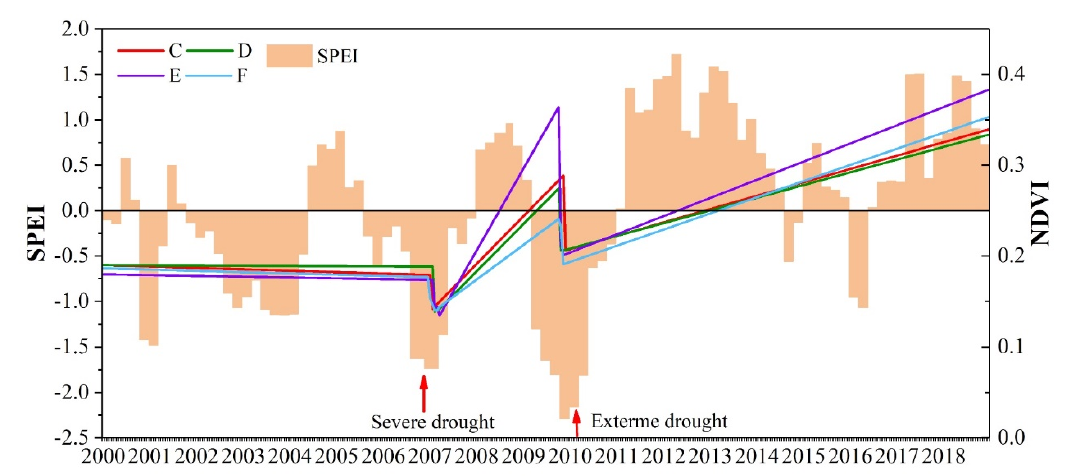
Figure 7. The 5-month (May–September) standardized precipitation evapotranspiration index (SPEI) (orange bar) and NDVI trend (line) components decomposed by BFAST at Qianan station. C, D, E, F, respectively, represent the NDVI trend for 4 pixels near the site extracted by BFAST.